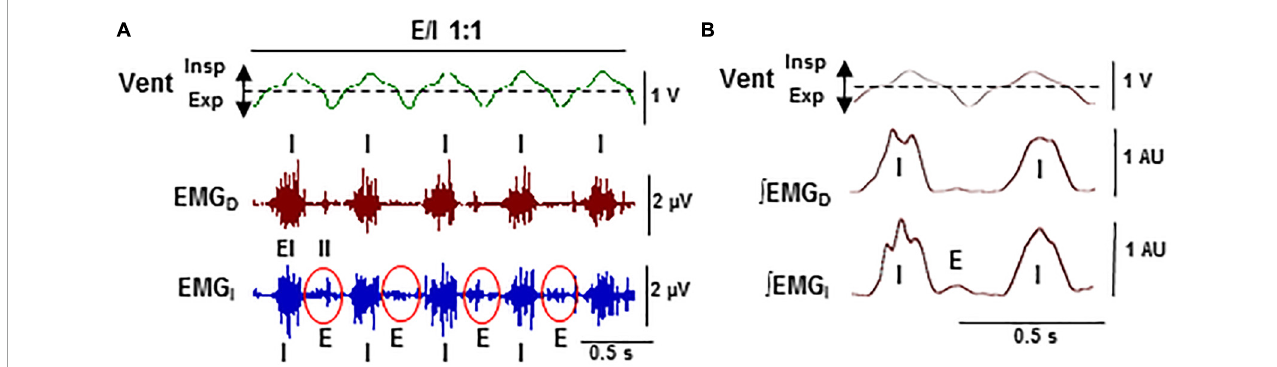
FIGURE6 Stabilization of expiratory–inspiratory coupling in high CO 2 causes the suppression of Cheyne–Stoke breathing. Detail of Figure 5B-c . (A) Records of the ventilatory motion ( Vent ; Insp and Exp , inspiration and expiration) and raw EMG of the diaphragm and intercostal muscles ( EMG D , EMG I ; EI and II , external and internal intercostals). (B) Average of ventilation signal ( Vent ) and fully rectified EMG signals ( R EMGD, R EMGI ; N = 20 breathing cycles). Note the stable 1:1 alternation in antiphase ( E/I 1:1 ) of the synchronous inspiratory activities of the diaphragm and the external intercostal muscles ( I ) with the activity of expiratory internal intercostal muscles ( E